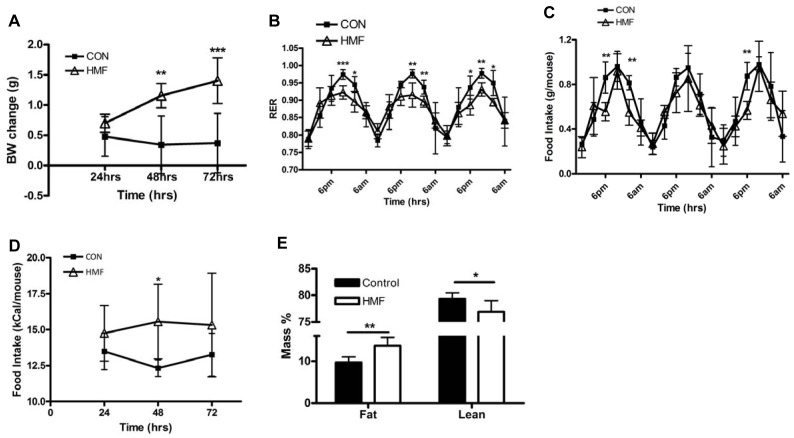
Metabolic and body composition changes in response to 3 day HMF feeding.The mouse metabolic research unit was utilized to analyze (A) body-weight changes, (B) respiratory exchange ratio (RER) and (C&D) food-intake in mice fed a three day control or 42% HMF diet. (N = 5) (E) Fat and lean mass were measured using MRI. (N = 5).